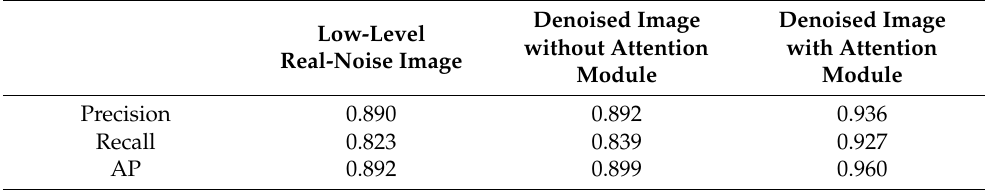
Table 3. Precision, recall, and average precision (AP) on low-level real-noise images and the corre- sponding denoised images with and without attention module.